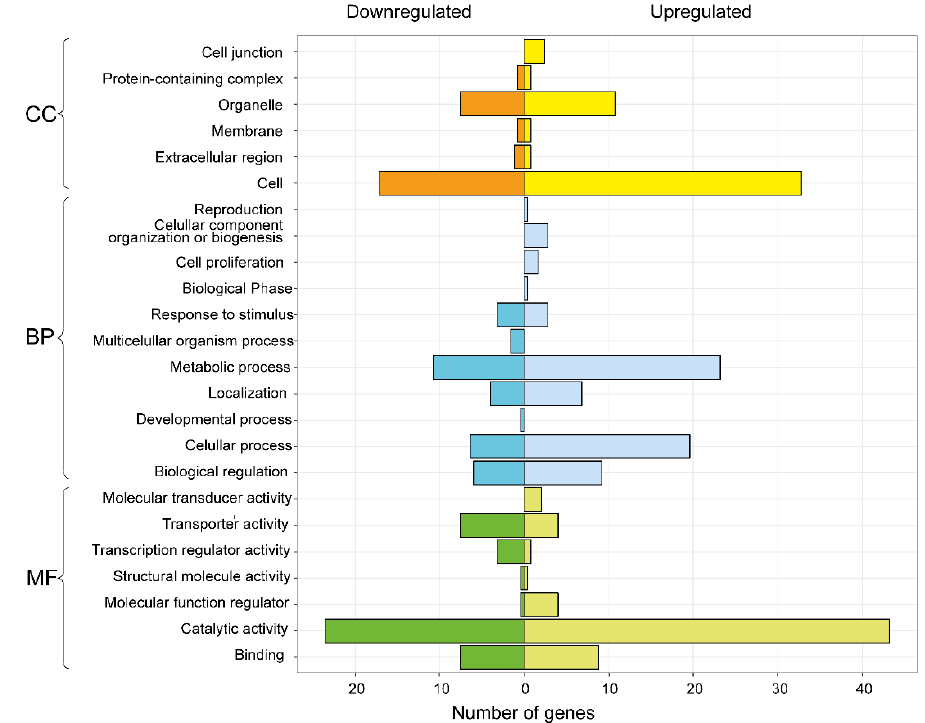
Figure 4. Gene ontology distribution of Eucalyptus globulus transcripts according to level 1 categories: GO, Cellular Component (CC), Biological Process (BP) and Molecular Function (MF). Genes are di ff erentially expressed in treatment compared to control condition.